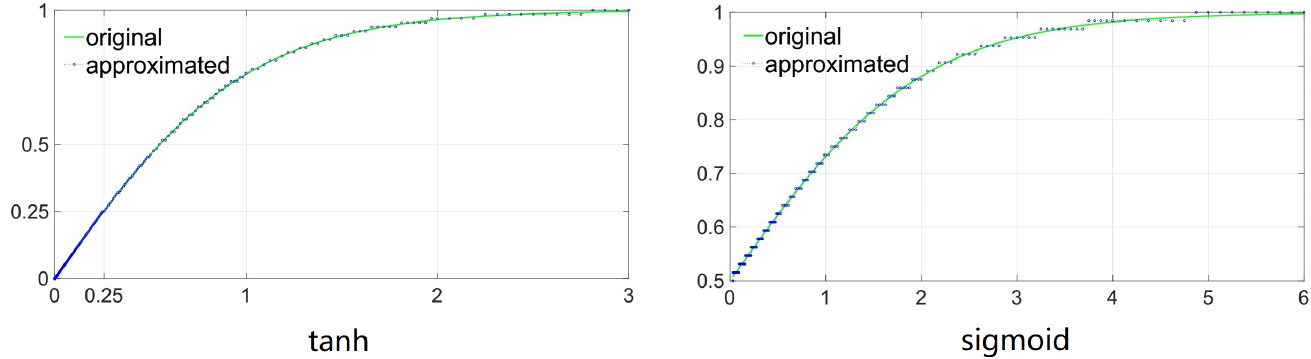
Figure 6. Comparison between approximated activation function and the original